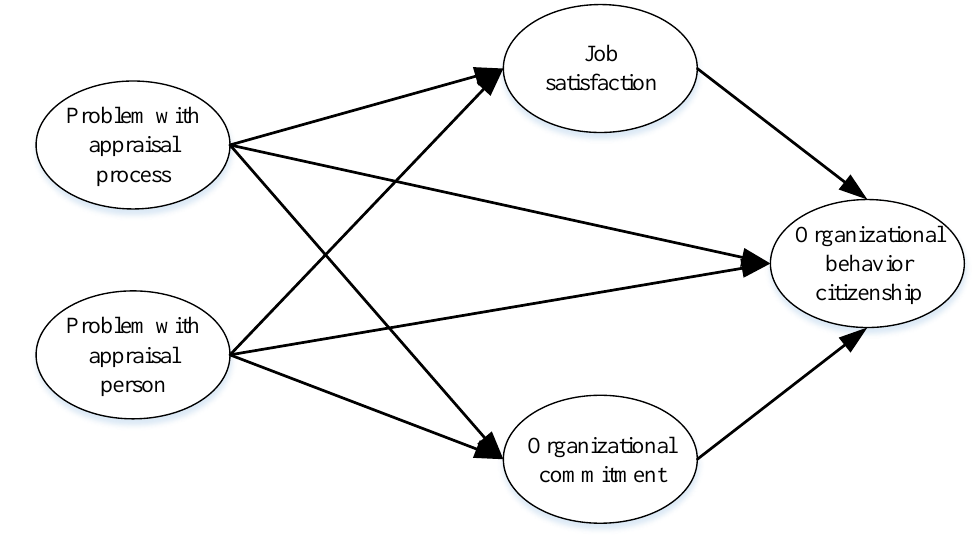
Figure 1. Conceptual research framework.